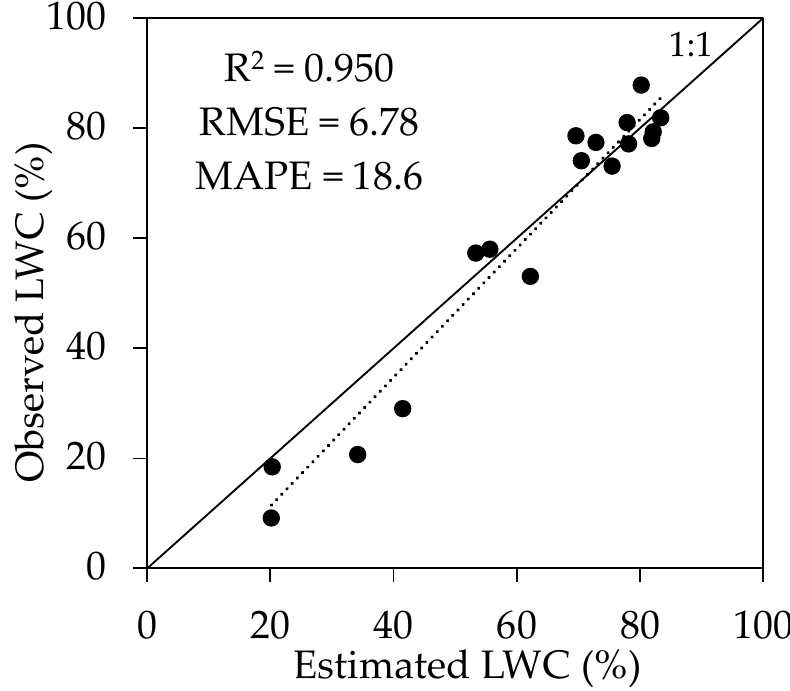
Figure 7. Comparison between estimated and observed leaf water content (LWC). The solid line denotes 1:1 and the dashed line denotes the regression line.